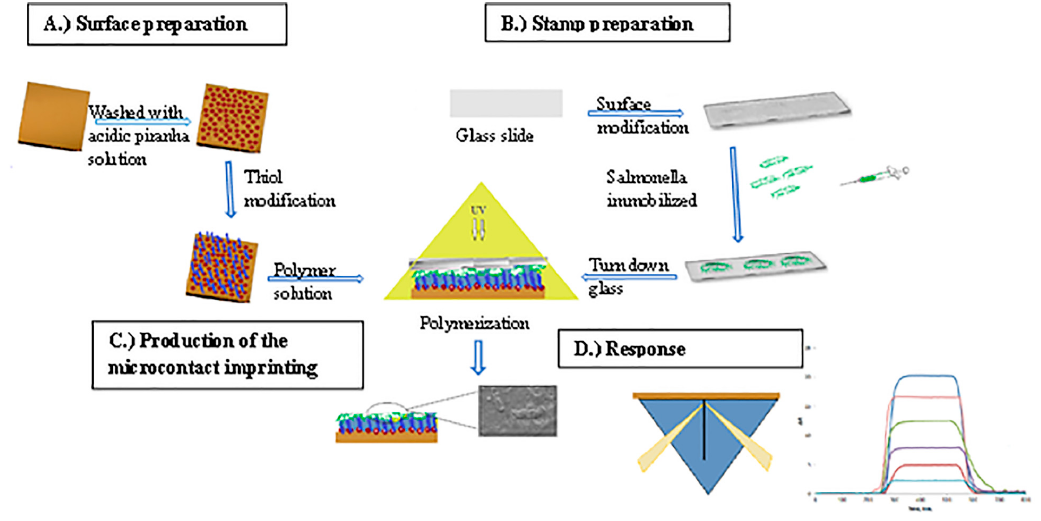
Figure 1. Schematic representation of microcontact imprinting of S. paratyphi onto the SPR chip. ( A ) preparation of SPR chip surface, ( B ) preparation of S. paratyphi stamps, ( C ) production of the microcontact imprinting and ( D ) response of the SPR sensor system.